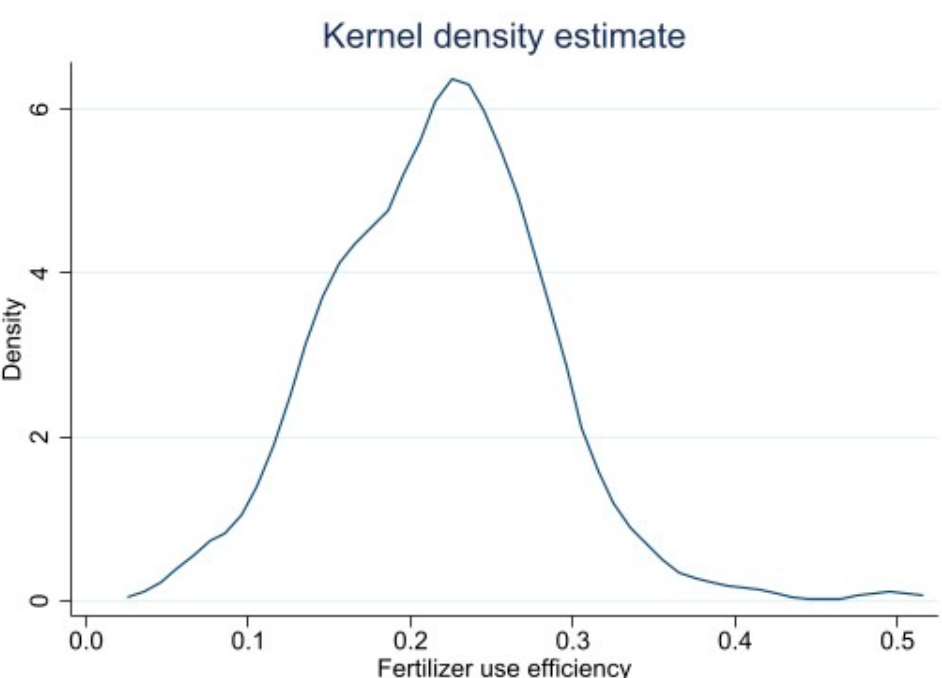
Figure 2. Kernel density distribution of fertilizer use efficiency. Table 1. Technical efficiency and fertilizer use efficiency scores.